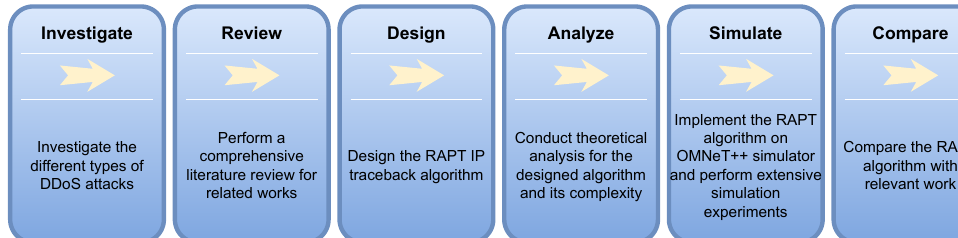
Figure 1. Research methodology